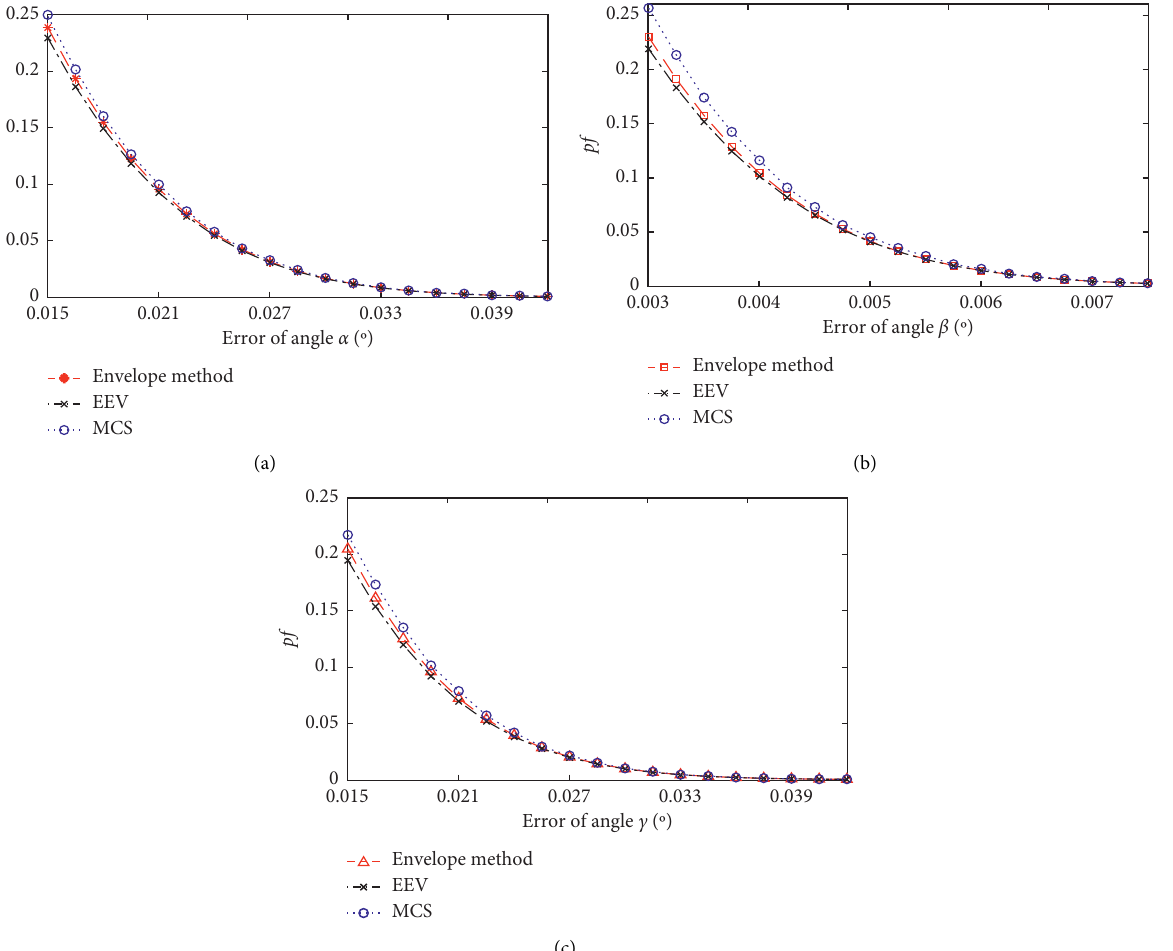
Figure 10: Reliability of robot attitude. (a) Failure probability of angle α . (b) Failure probability of angle β . (c) Failure probability of angle c